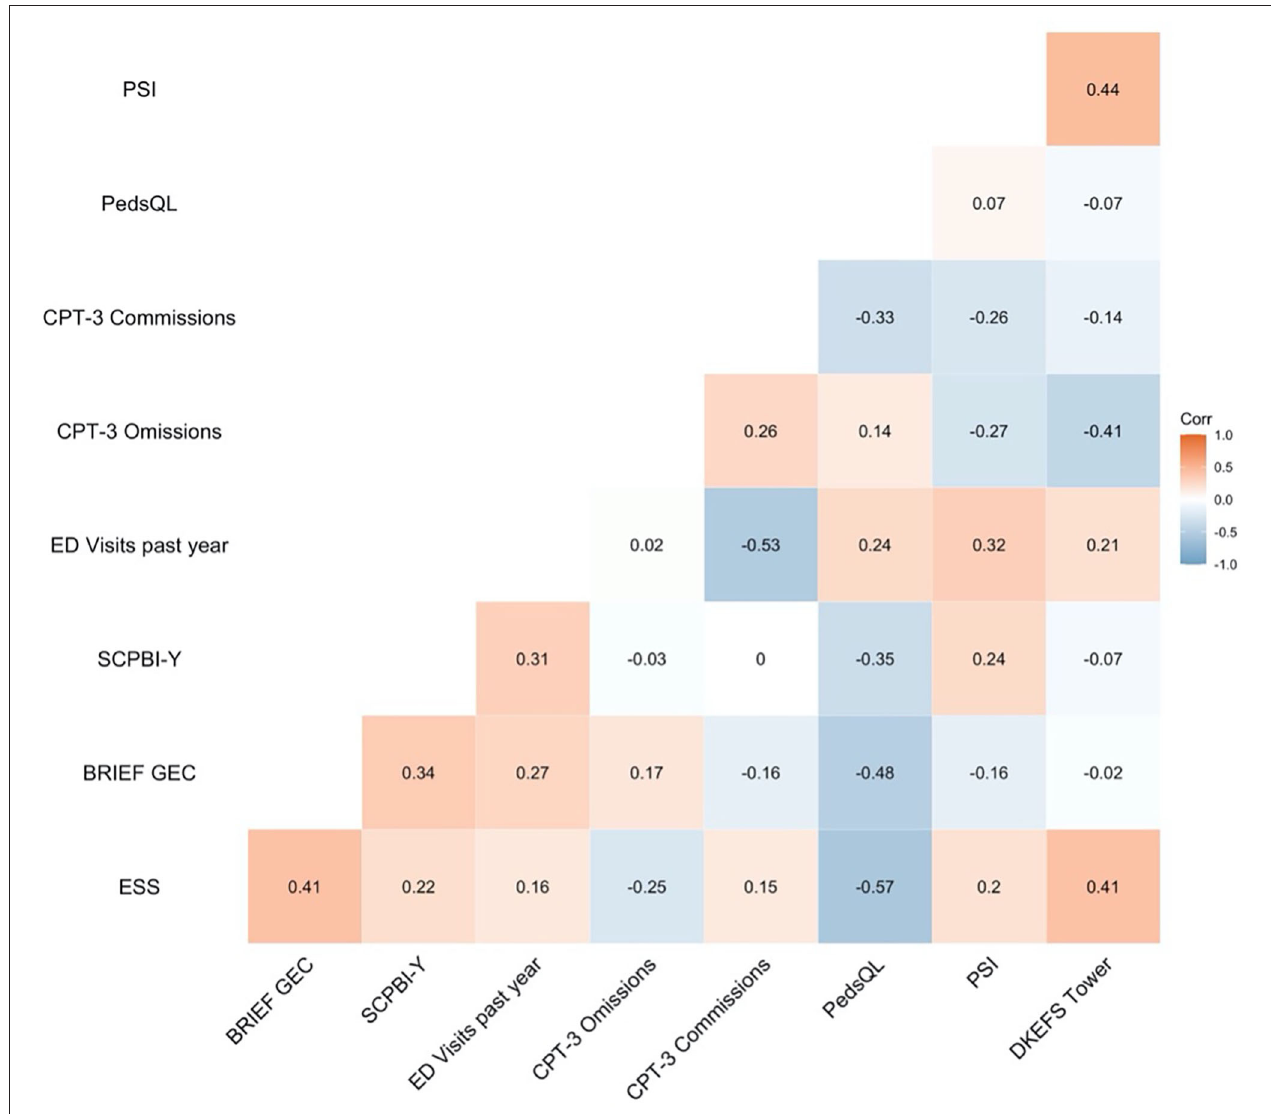
FIGURE 3 | Bivariate correlations of patient-reported outcomes, emergency department visits, and cognition. SCPBI-Y, Sickle Cell Pain Burden Interview-Youth; Conners’ Continuous Performance Test-Third Edition, CPT-3; ED, emergency department; PedsQL, Paediatric Quality of Life Inventory HRQOL; DKEFS, Delis-Kaplan Executive Function System; BRIEF GEC, Behavioural Rating Inventory of Executive Function Global Executive